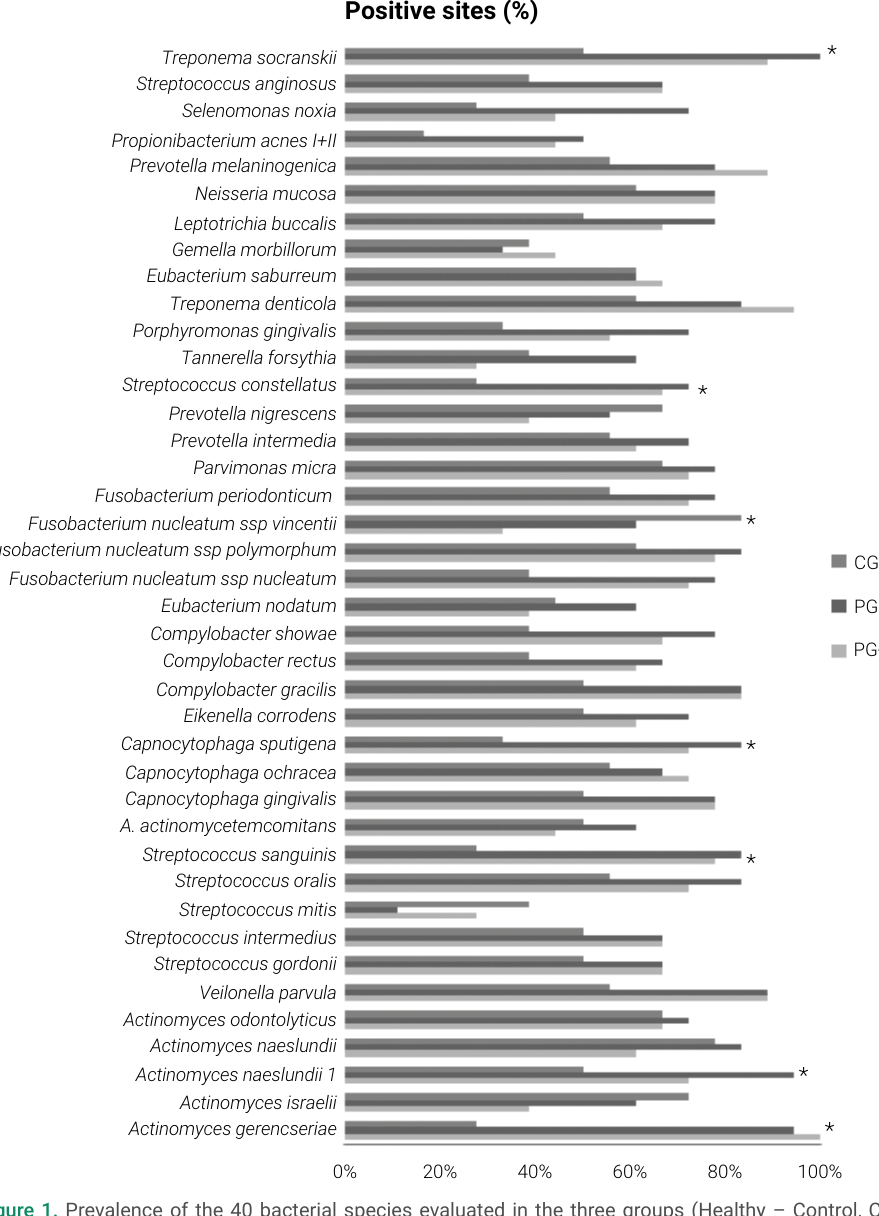
(Figure 1). F . nucleatum ssp vincentii was the only bacteria statistically more prevalent in CG and PG-T than in PG-C (CG (84%)= PG-T (61%)>PG-C (33%), p< 0.009) (Figure 1).